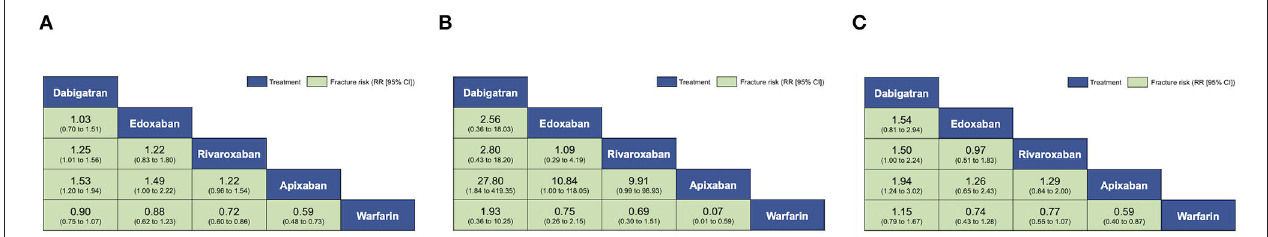
FIGURE 3 | Pooled estimates of the network meta-analysis. Comparisons, column vs. row, should be read from left to right and are ordered relative to overall effectiveness. (A) Pooled risk ratios (95% confidence intervals [CI]) for all fractures. (B) Pooled risk ratios (95% CI) for spinal fractures. (C) Pooled risk ratios (95% CI) for hip